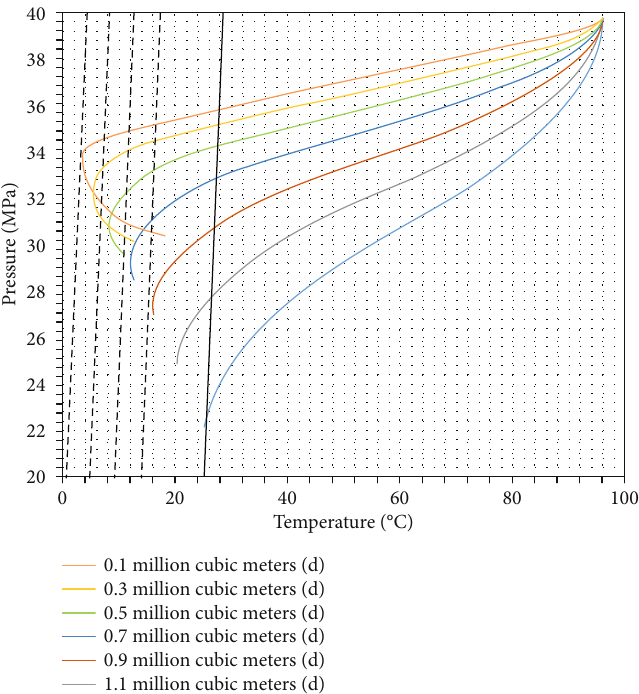
Figure 8: Judgment chart of gas hydrate formation in well